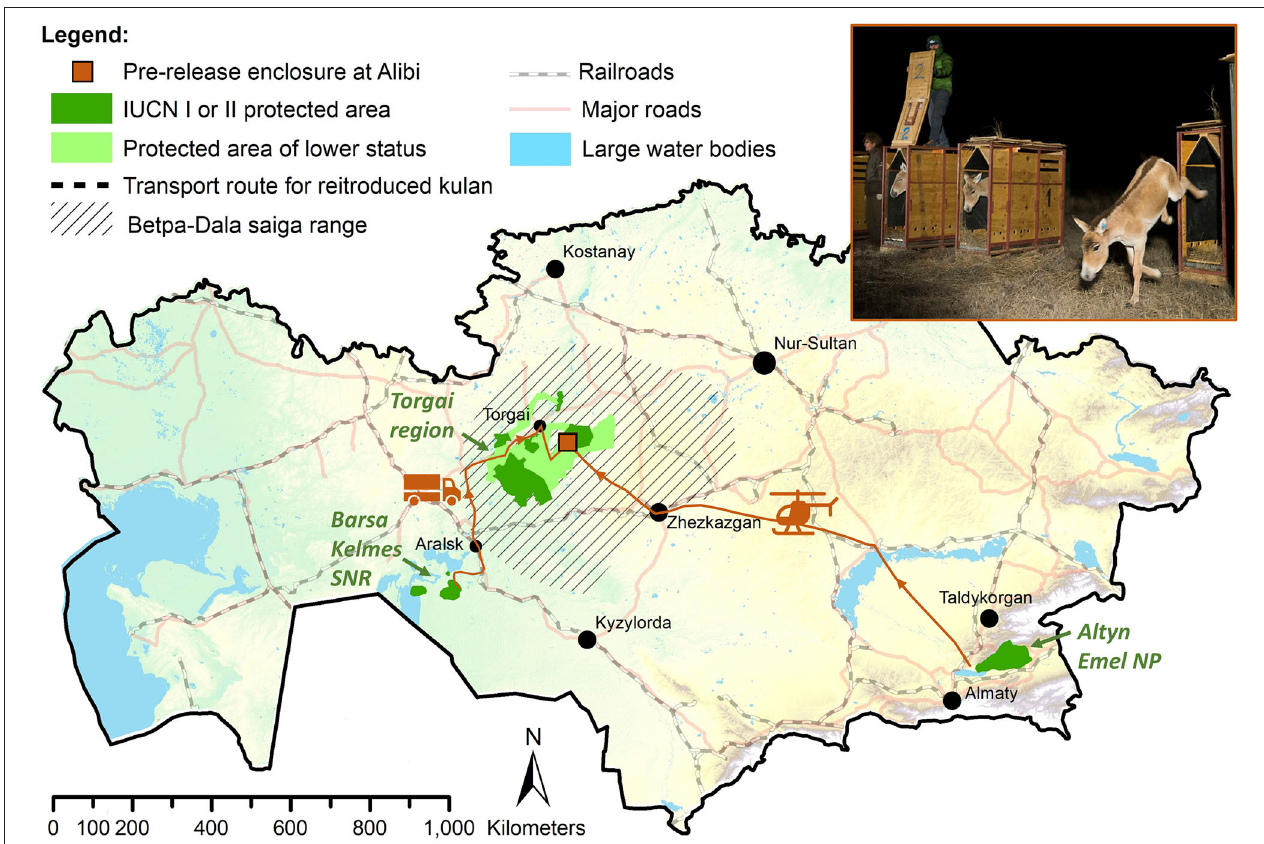
FIGURE 1 | Study areas of kulan in Kazakhstan. Nine kulan were reintroduced to the Torgai region in central Kazakhstan from Altyn Emel National Park (NP) in 2017 and two kulan from Barsa Kelmes State Nature Reserve (SNR) in 2019. Photo: Daniel Rosengren, Frankfurt Zoological Society.